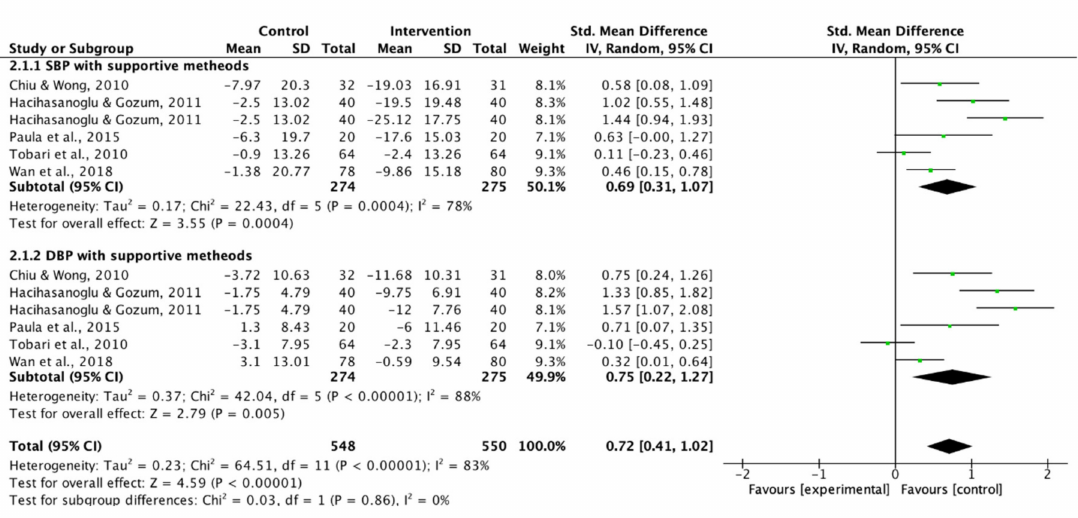
Figure 9. Forest plot of theory-based interventions on diastolic blood pressure.